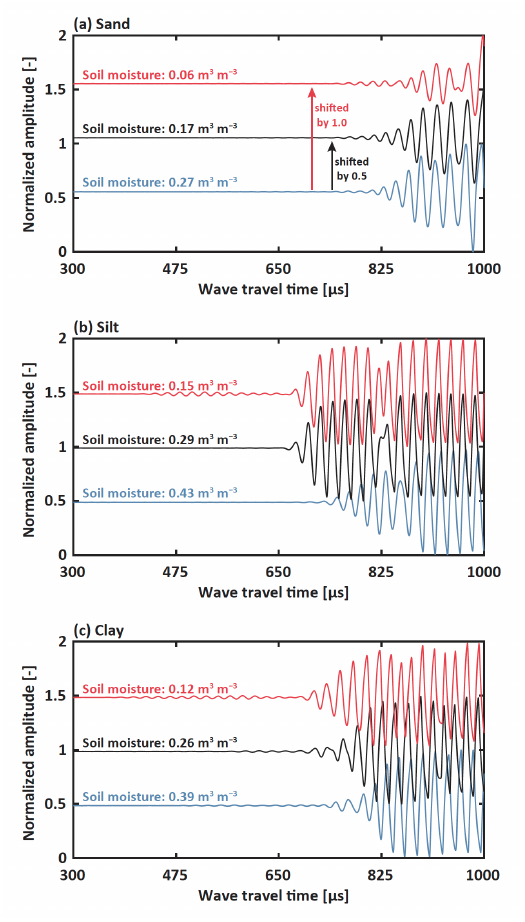
Figure 5. Obtained Waveforms for ( a ) sand ( b ) silt and ( c ) clay. Blue, black, and red colors represent nearly saturated, humid, and dry soil moisture, respectively, under different soil types. For vi- sualization purposes, black and red lines were shifted by the normalized amplitude of 0.5 and 1.0,